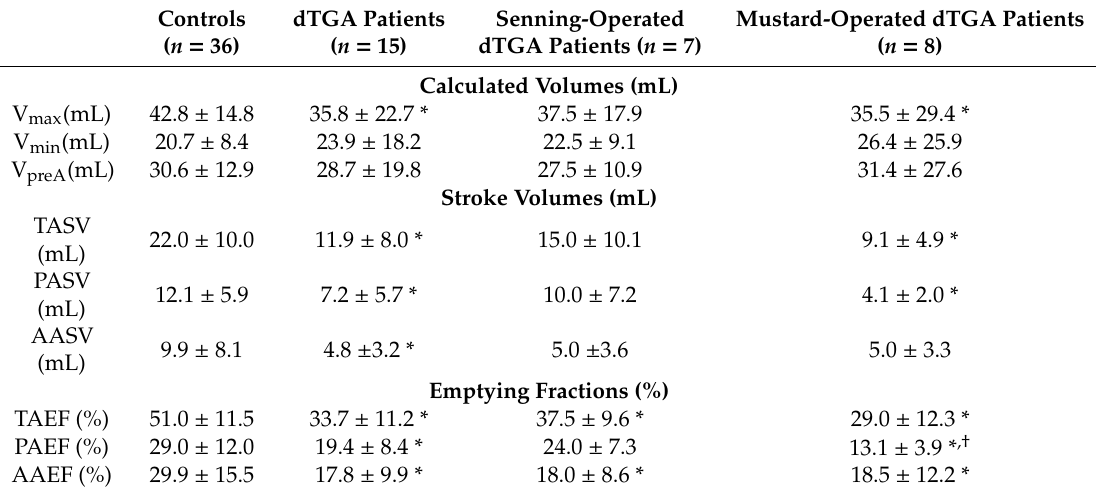
Table 2. Comparison of three-dimensional speckle-tracking echocardiography-derived volumetric left atrial parameters of patients with dextro-transposition of the great arteries and those of controls.